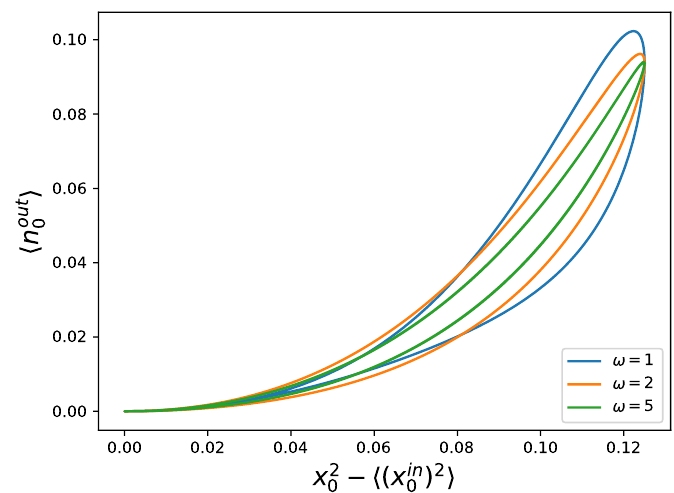
(cid:105) of the outgoing beam versus the second-moment of the quadrature Figure 6. Number of photons (cid:104) n out 0 ) 2 (cid:105) for squeezed states, displaying a pinched hysteresis loop, proving that this of the input state (cid:104) ( x in 0 system behaves as a memristor. We have plotted this for three different frequencies, namely ω = 1 (blue), ω = 2 (orange), and ω = 5 (green), exemplifying that the area of the loop decreases for higher frequencies. We have used φ ( 0 ) = π , ω 0 = 5, α = 0.5, and x 0 = 1/4 (see Appendix A for directions of 2 the hysteresis